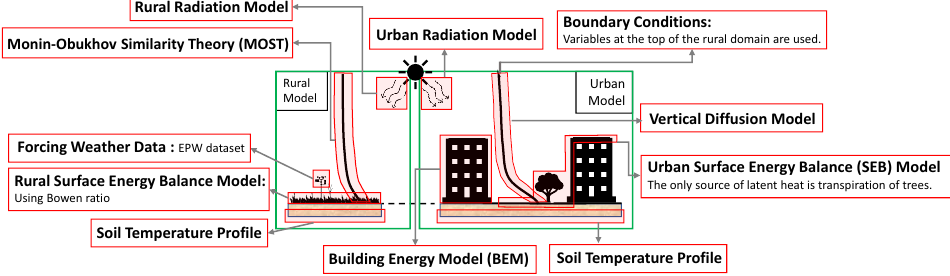
Figure 1. Overview of the Vertical City Weather Generator (VCWG) model and the integration of